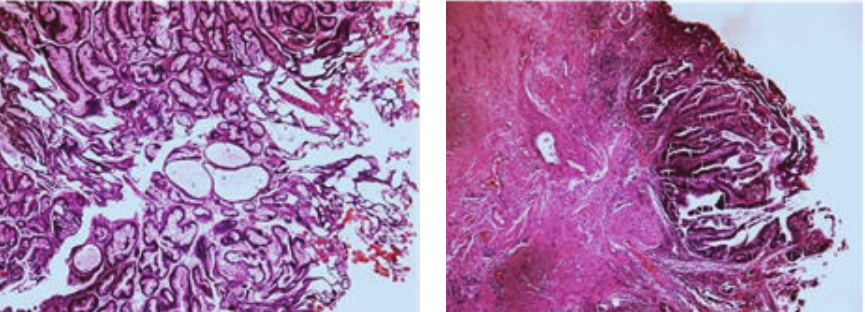
Figure 4: Photomicrographs of the vesical lesion, intestinal mucinous carcinoma, originated from tubular polyp with low-grade dysplasia.